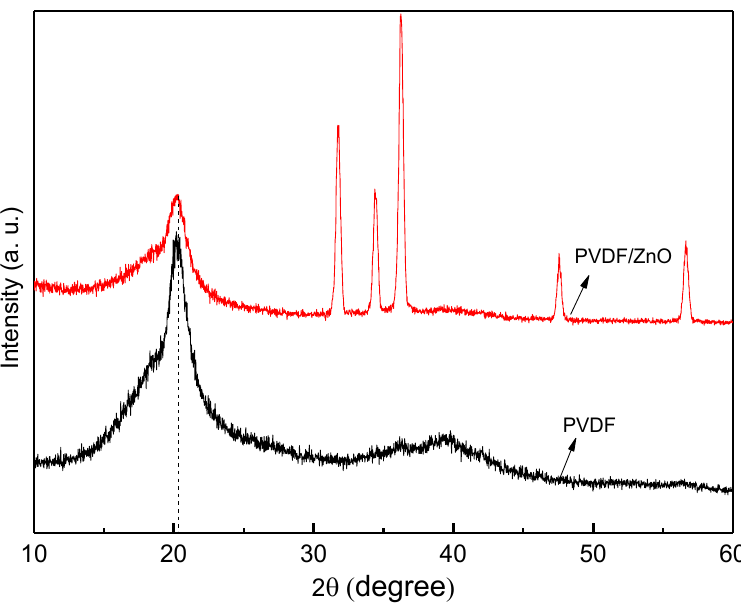
Figure 5. X-ray diffraction pattern of spin coated PVDF/ZnO composite structure.